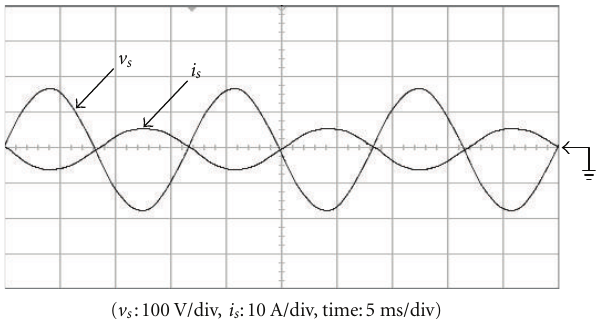
Figure 25: Experimental result: the filtered line current and line voltage during the interval of medium insolation.